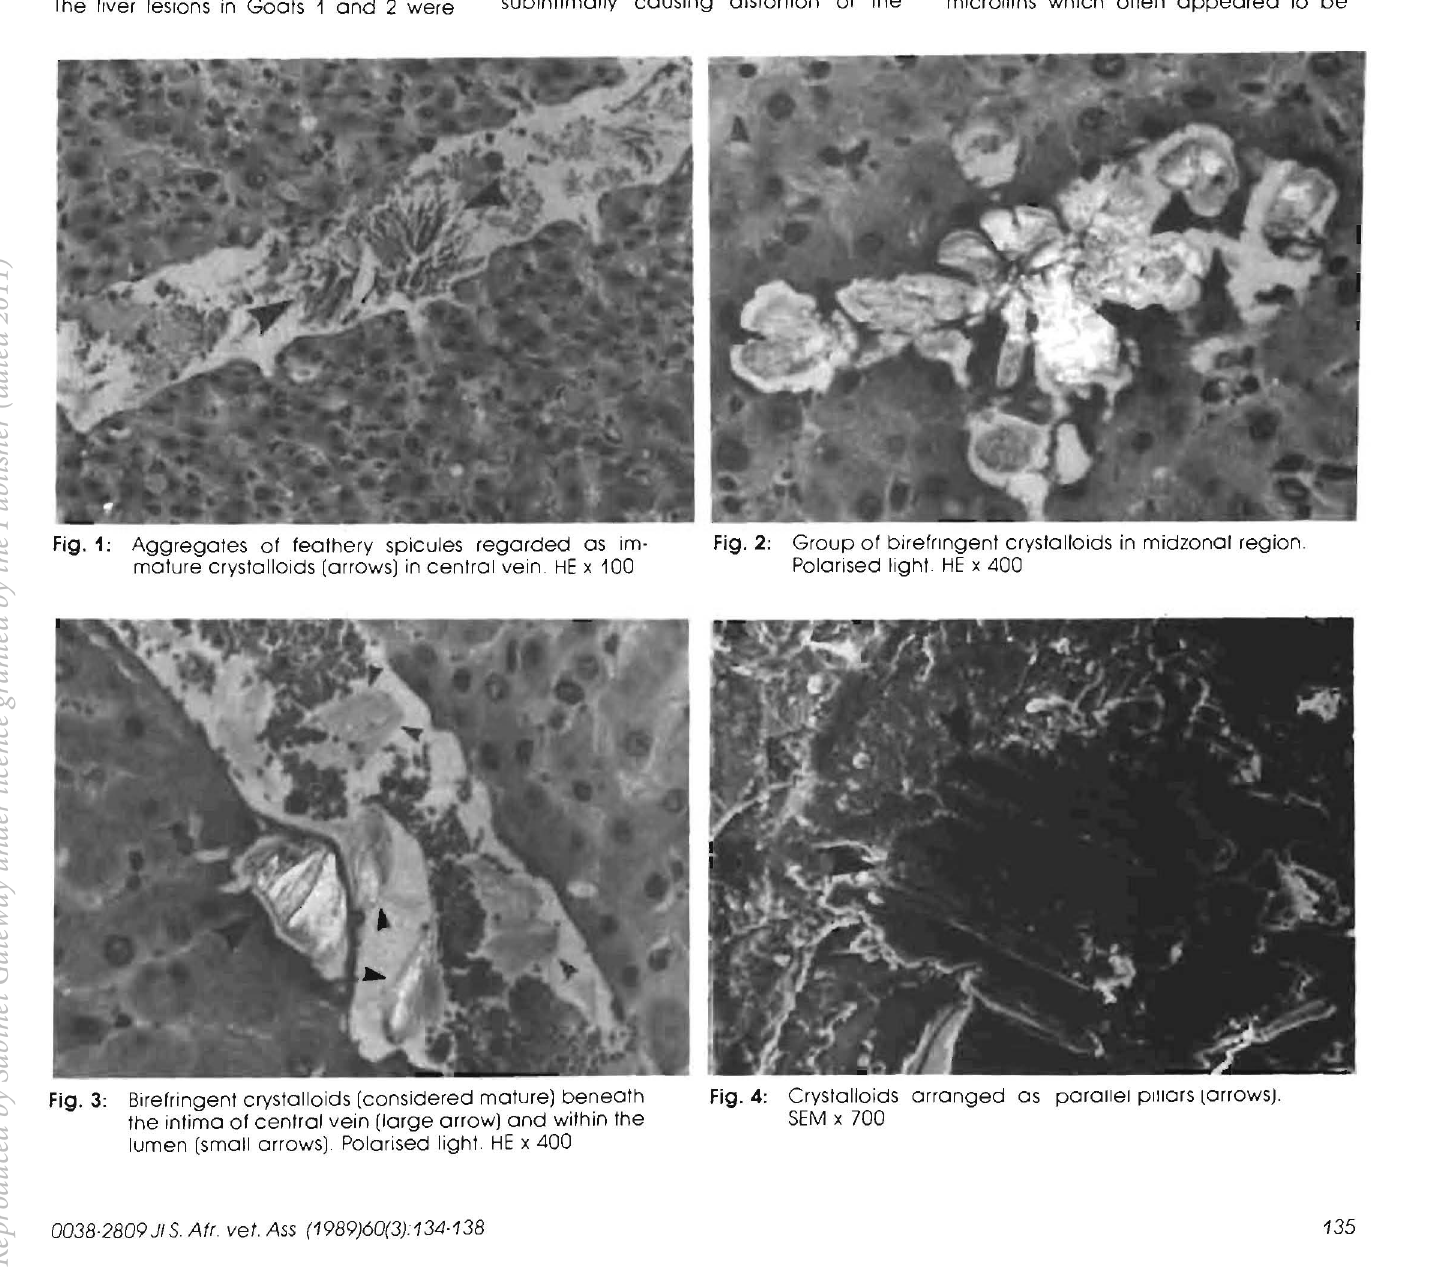
Fig. 4: Crystalloids arranged as parallel pillars larrOwS)_ SEM x